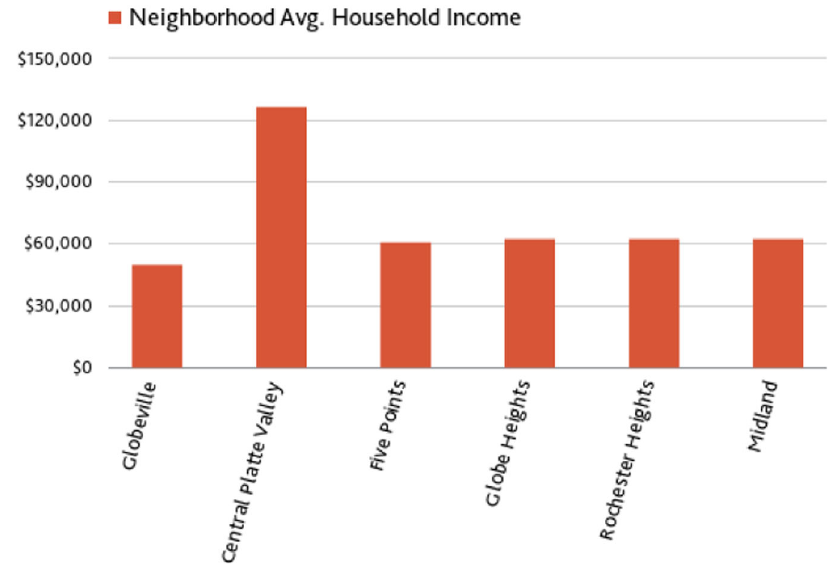
Fig. 6 Household Income in Globeville (Source: Citi-data,